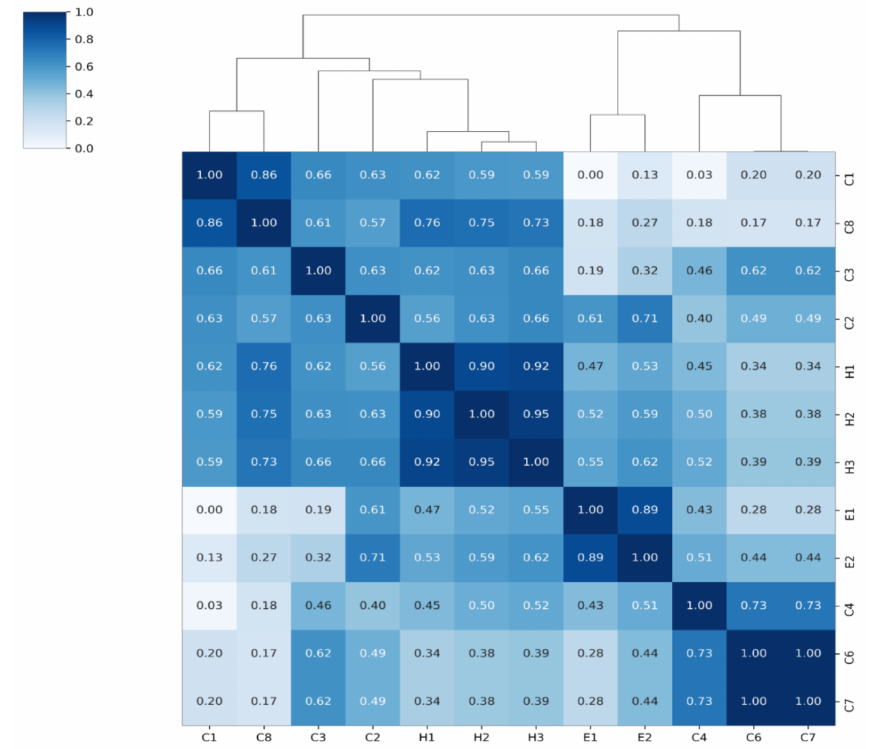
Figure 1. Heat map of the clustered Policies. The Pearson’s correlation matrix of the clustered polices using the hierarchical clustering with 1-correlation distance. H1, H2, H3 form the Health Index, E1, E2 form the Economic Index, C4, C6 and C7 form the Restriction Index while C1, C8, C2 and C3 form the Closing Index. Table 2. Korean government Index. The Korean Government Index is quantified from the Korean government’s social distancing levels issued by the Korean government in response to the COVID-19 situations in the country. Levels Idea Level Description